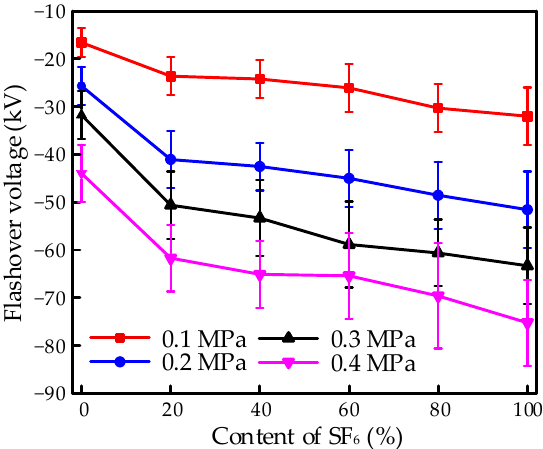
Figure 3. Relation between the flashover voltage and the content of SF 6 with various pressures under the finger-type electrode system.